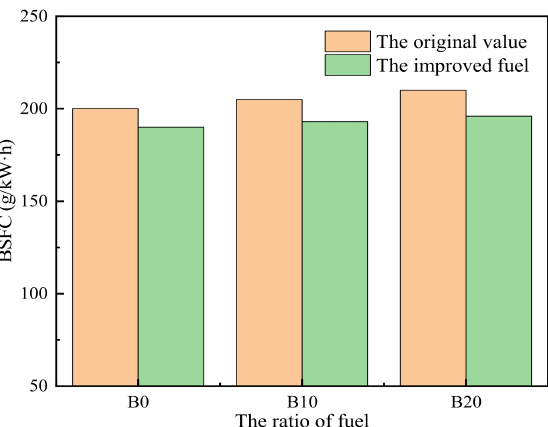
Figure 8. Comparison between the improved BSFC and the original value under 75% load.